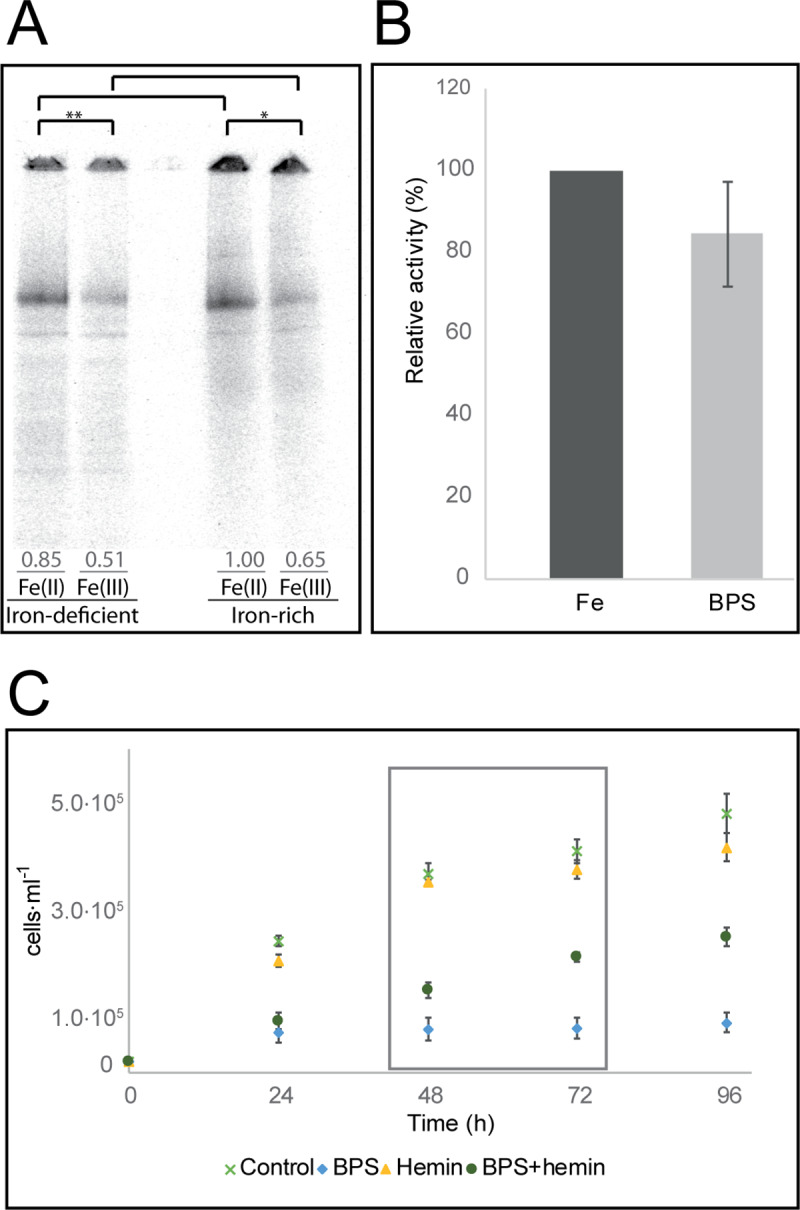
Iron uptake in N. fowleri.(A) Ferrous and ferric iron uptake by N. fowleri precultivated under iron-rich and iron-deficient conditions. Autoradiography of blue native electrophoresis gels of whole cell extracts from N. fowleri previously cultivated for 72 hours under iron-deficient conditions (25 μM BPS) or iron-rich conditions (25 μM Fe-NTA) and further incubated with 55Fe(II) (ferrous ascorbate) or 55Fe(III) (ferric citrate). Equal protein concentrations were loaded, and the loading control is shown in S1(A) Fig. The gel is representative of three independent replicates. Numbers indicate average relative densitometry values for the appropriate lines. Significant differences between band densitometry values are denoted by asterisk (*, p<0.05; **, p<0.01). (B) Ferric reductase activity under iron-rich and iron-deficient conditions. Relative values of N. fowleri ferric reductase activities in the iron-rich (Fe) and iron-deficient (BPS). The difference between the two conditions was not significant, p-value >0.05. Data are presented as the relative percentage ± SD from three independent replicates. (C) Growth restoration of N. fowleri in culture by hemin under iron-deficient conditions. Cells in regular growth medium (control) and with 50 μM hemin (hemin) exhibited similar levels of propagation, while the cells under iron-deficient conditions, achieved with 50 μM chelator bathophenanthroline disulfonic acid (BPS), showed stagnated growth in the first 24 hours. The addition of 50 μM hemin to the iron-deficient medium (BPS+hemin) partially restored culture growth. The boxed area indicates the time from which growth restoration was calculated. Data are presented as the means ± SD from four independent replicates.